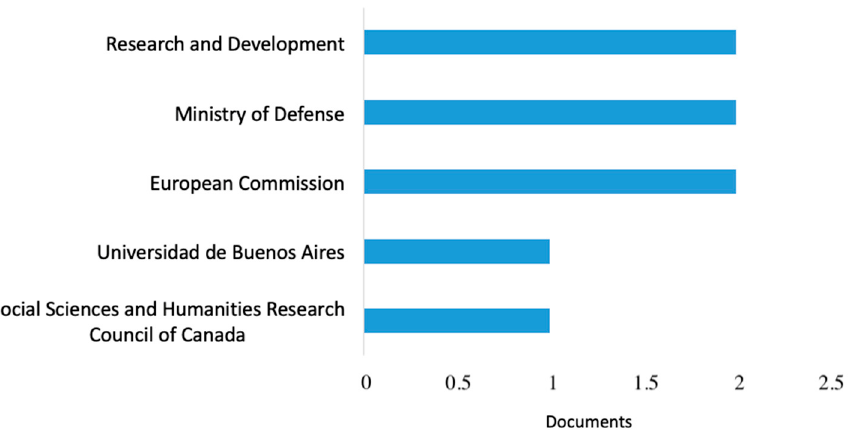
Figure 3. Documents by funding sponsor (top five funding sponsors) (source: own authorship).